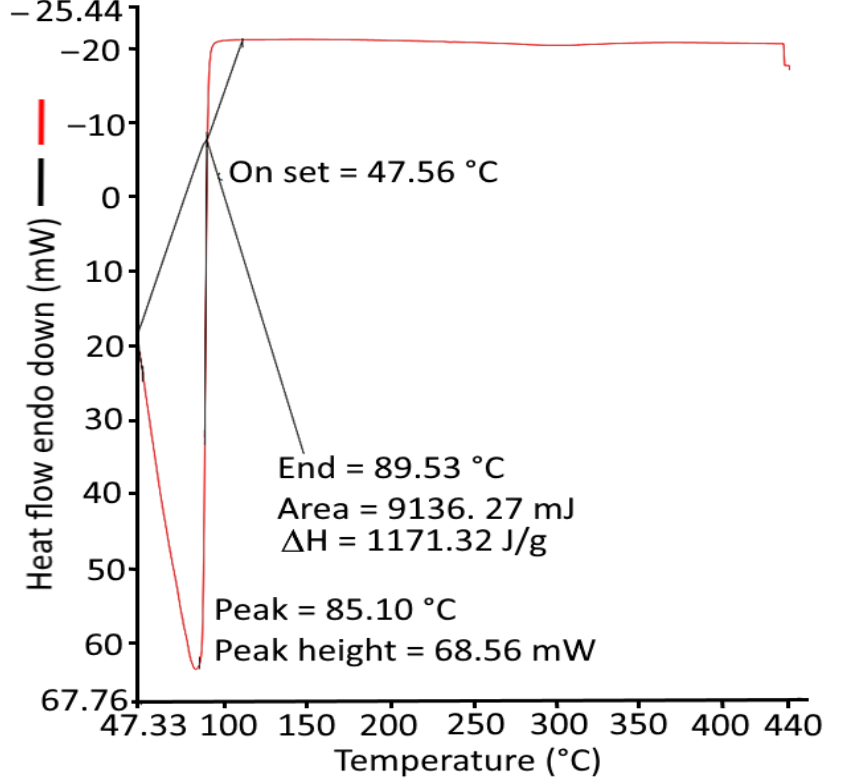
Figure 5. Differential scanning calorimetry spectra of Azadirachta indica oil included in the nanohy- drogel.